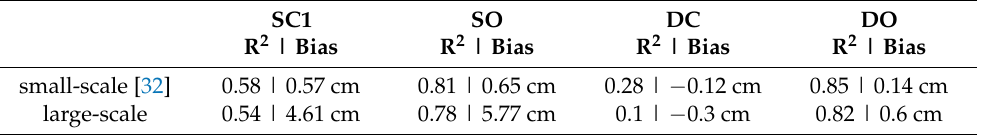
Table 2. Comparison of wave statistics between the small-scale (adapted from [32]) and large- scale (this study) applications based on the coefficient of determination (R 2 ) and the bias for each hydrodynamic